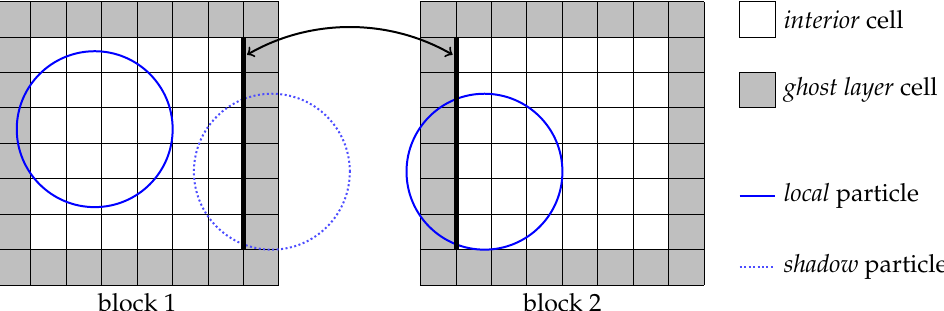
Figure 4. Domain partitioning into blocks. The cell-based fluid simulation requires a ghost layer for synchronization. The particle simulation uses shadow particles. The two bold vertical lines denote the common face of both blocks.